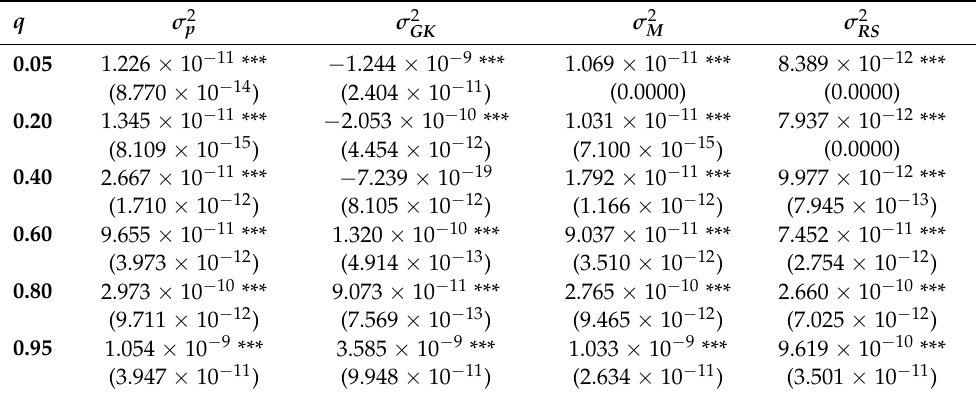
Table 5. Trading volume impact on Piraeus Bank’s stock return